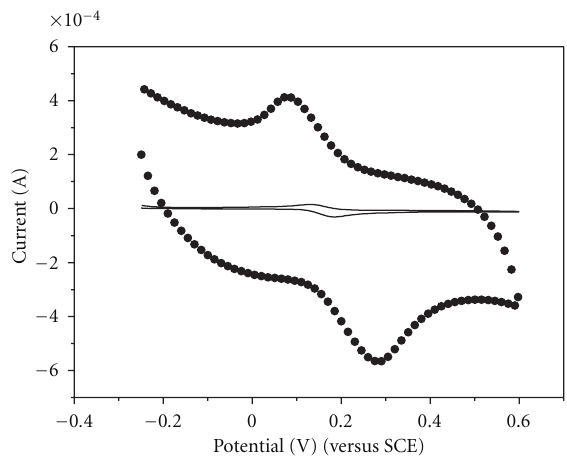
Figure 2: Cyclic voltammogram of 5 × 10 − 5 M DA in 0.2 M phosphate bu ff er solution at bare CPE (dashed line) and poly (gabapentin) film-coated carbon paste electrode (solid line) at 0.1Vs − 1 scan